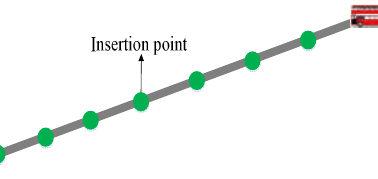
Figure 6. Some insertion points are placed in the path.